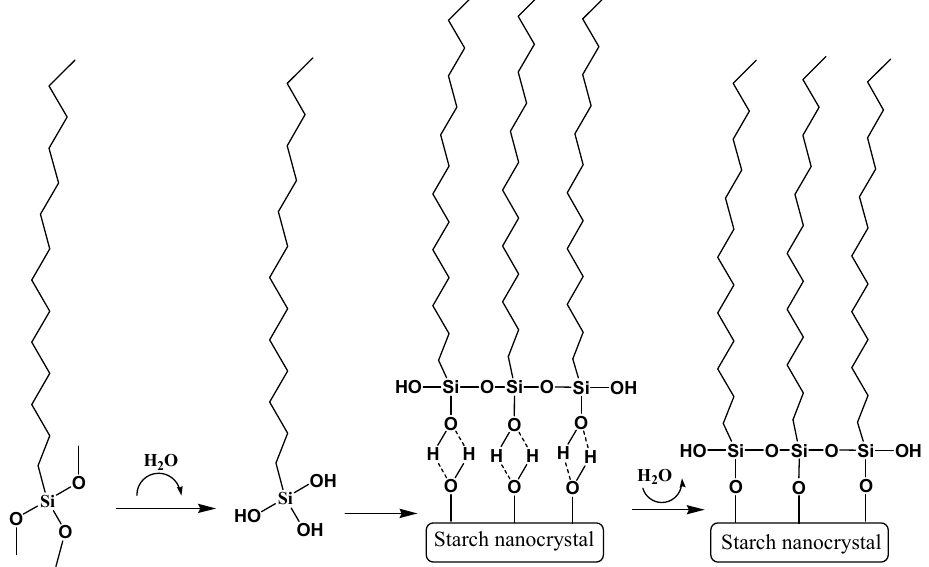
Figure 11. Reaction scheme between hexadecyltrimethoxysilane (HDS) and starch nanocrystals (SNC). Adapted from [60], with permission from Elsevier and Copyright Clearance Center, 2016.